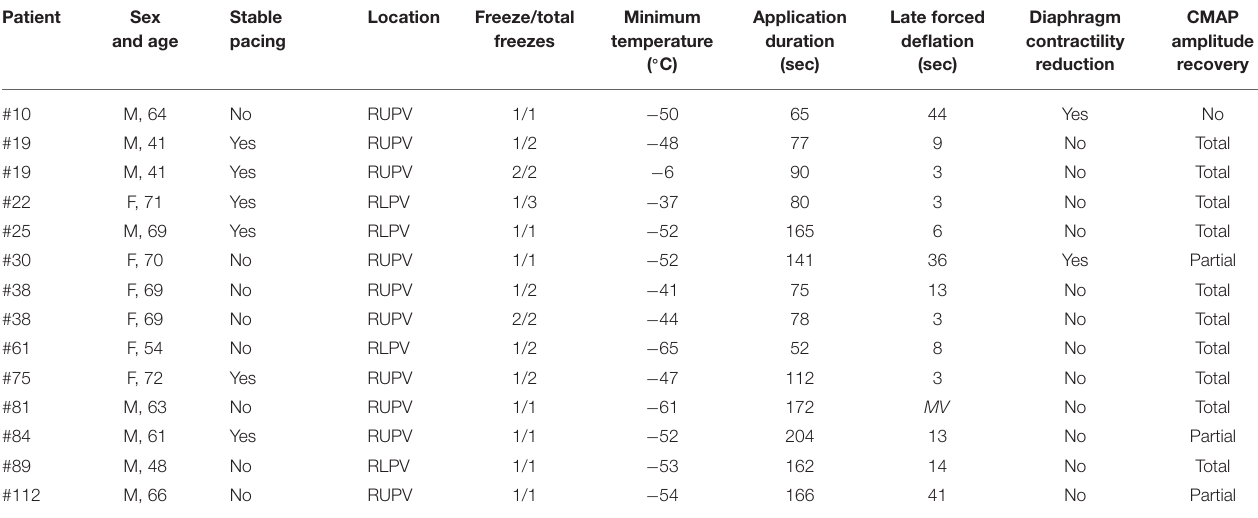
TABLE 3 | All patients (12) with phrenic threats (14) during cryoballoon ablation: demographic and technical data.